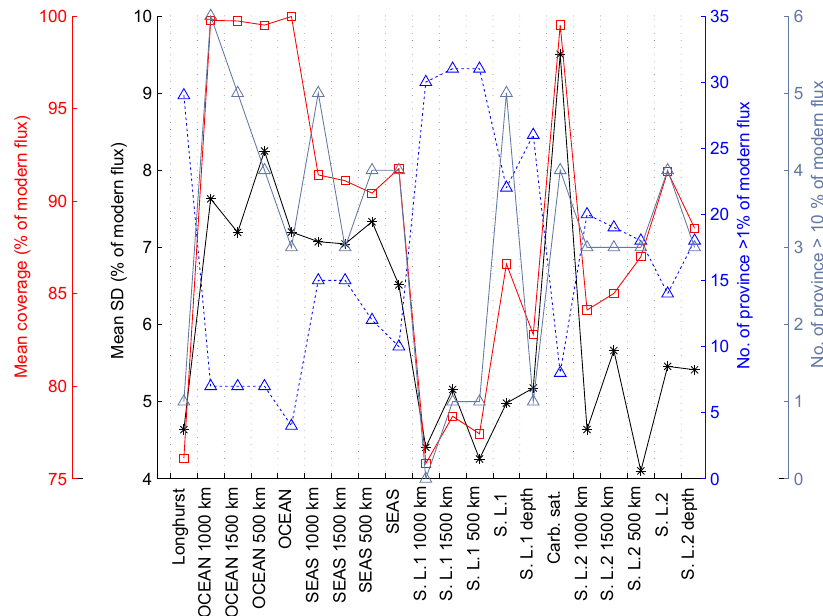
Figure A5. Summary of province-map experiments. Black symbols show the mean of the standard deviation at each time step of the bootstrap experiment for each province map. Red symbols show the mean coverage for the bootstrap experiment for each province map. The number of provinces accounting for more than 1% and 10% of the modern flux for each province map are shown by the blue and grey symbols, respectively.